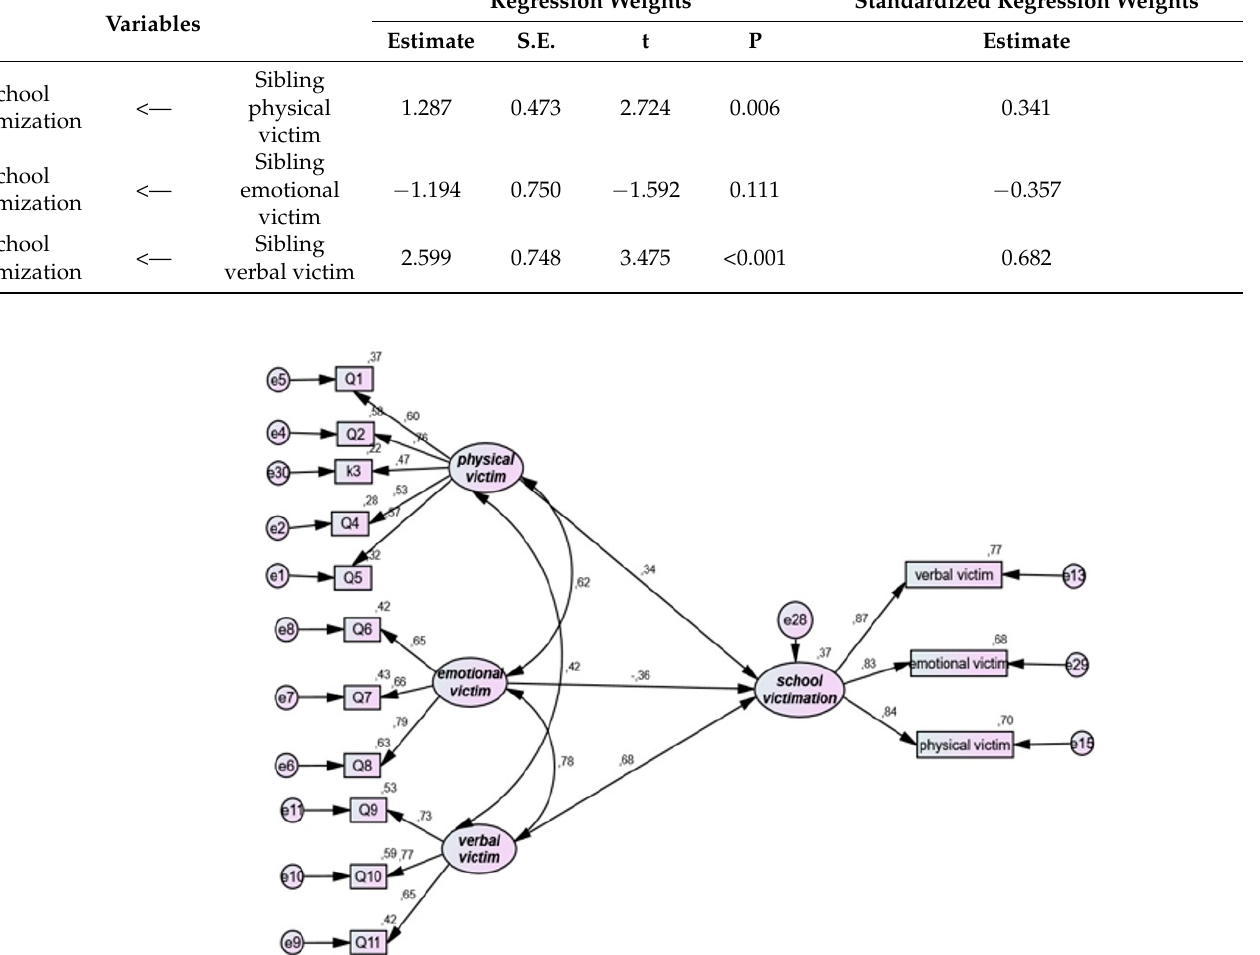
Table 2. Association of sibling physical, emotional, and verbal victimization with school victimization. Variables